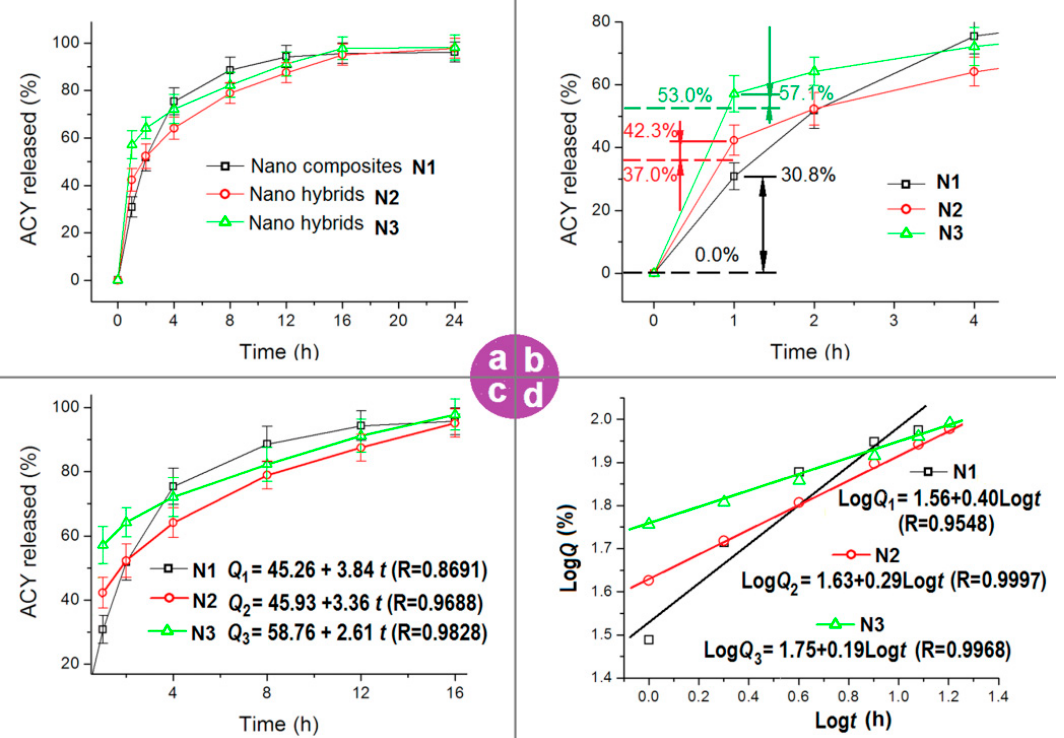
Figure 8. The modified release profiles of ACY by the composites of N1, the nanohybrids of N2 and N3, and the related analyses: ( a ) release profiles; ( b ) release profiles at the initial 2 h; ( c ) regressed results according to the zero-order kinetic equation; ( d ) regressed results according to the Peppas equations.